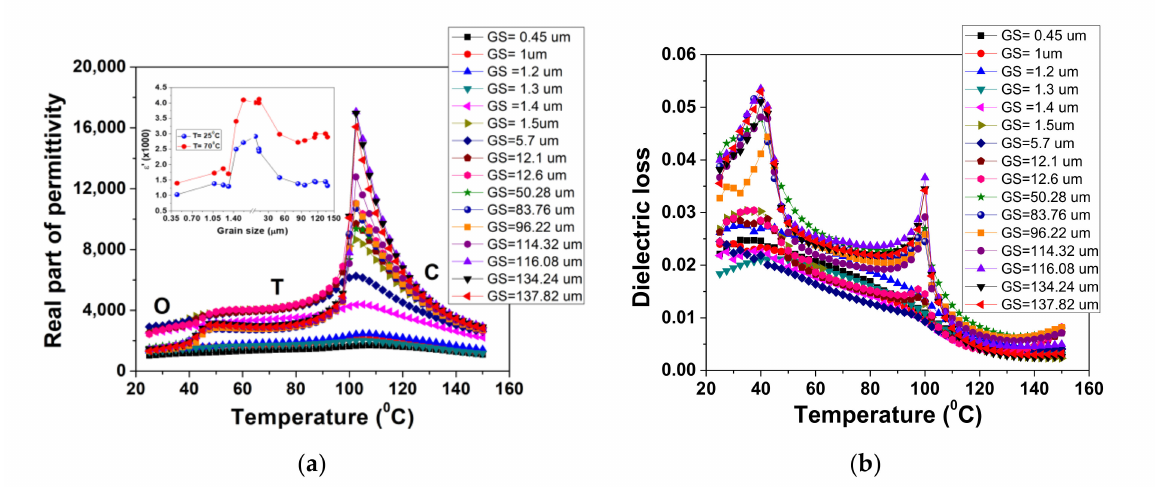
Figure 2. Temperature dependence of ( a ) real part of permittivity and ( b ) dielectric loss in BZT ceramics with di ff erent grain sizes at f = 10 kHz. Inset in ( a ): grain size dependence of dielectric permittivity at two selected